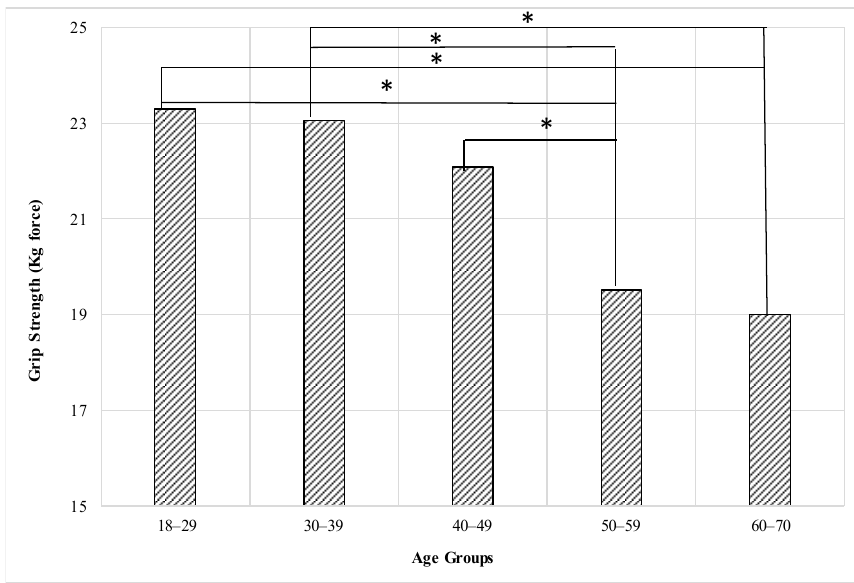
Figure 5. Effect of the age group on the grip strength of females (* means there is a significant difference between levels). Table 5. Summary of females’ grip strength results.